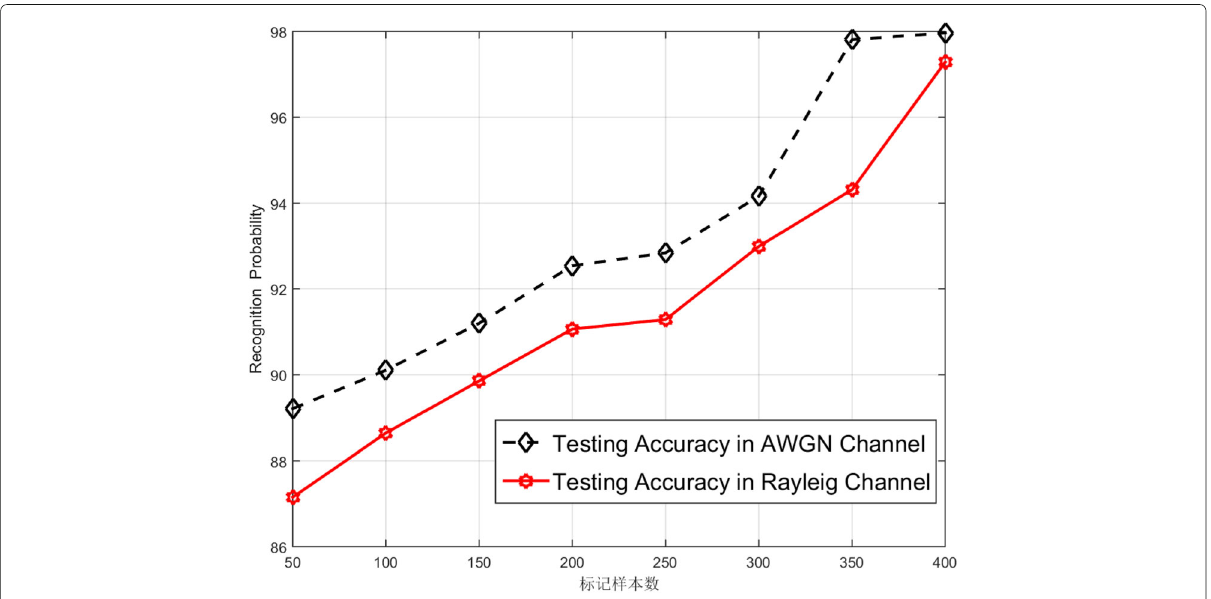
Fig. 7 The number of labeled sample effect for blind signal